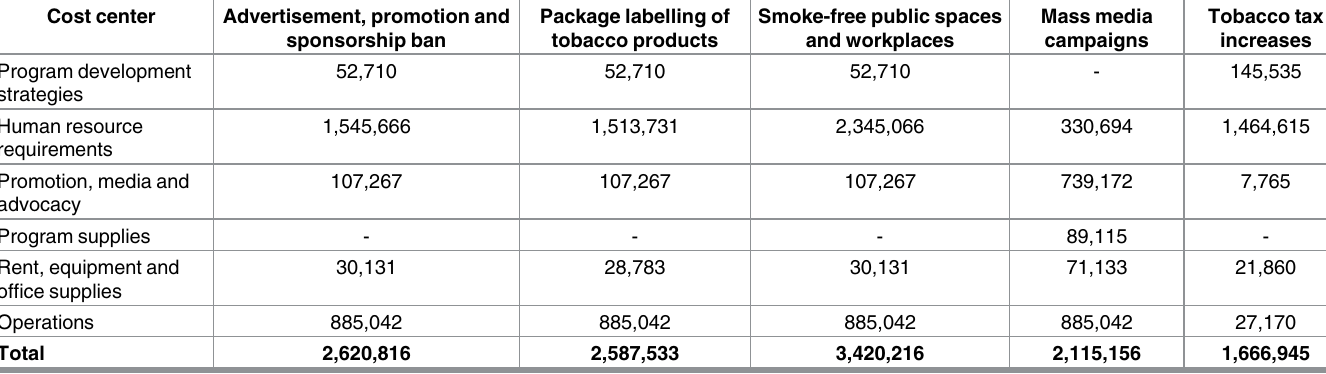
Table 7. Intervention cost of five demand-side tobacco control measuresin US$.